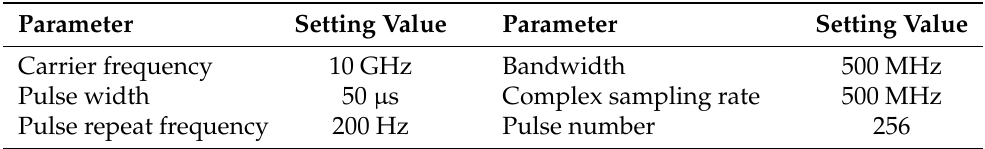
Figure 4. Target model and RD image. ( a ) Target model. ( b ) ISAR image based on RD algorithm. Table 1. Parameters of the radar